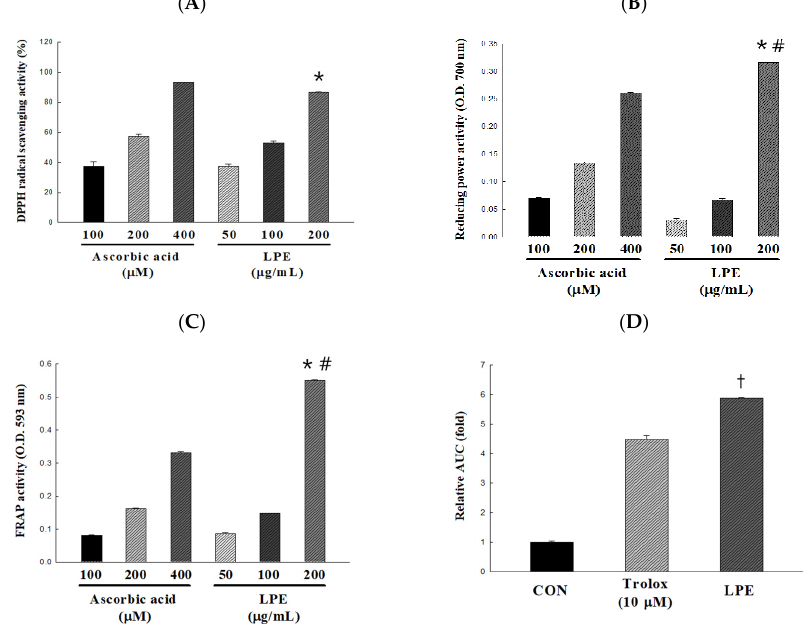
Figure 1. Antioxidant activity of the Potentilla rugulosa Nakai ethanolic extract (LPE) was established based on ( A ) DPPH radical-scavenging activity, ( B ) reducing power, ( C ) Ferric-ion reducing antioxidant power (FRAP) activity, and ( D ) areas under the curve fluorescence decay curve (AUC) value for ORAC. All values are presented as the mean ± SD. * p < 0.05 VS. 100 mg / mL of LPE; # p < 0.05 VS. 400 µ M of ascorbic acid; † p < 0.05 VS. 10 µ M of trolox, according to one-way analysis of